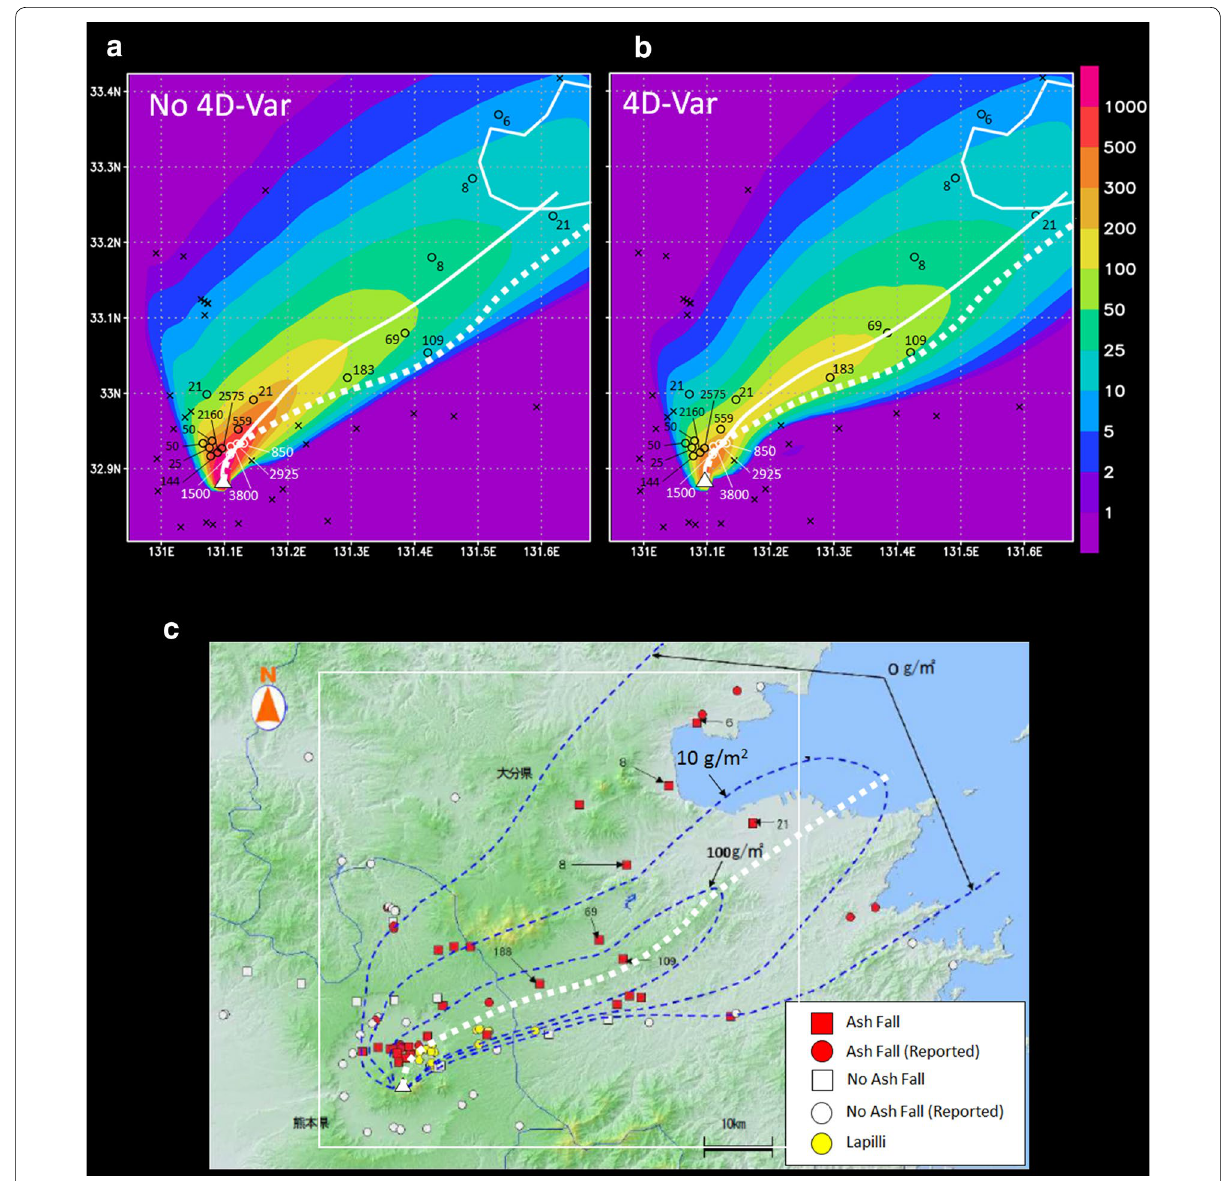
Fig. 2 a Ash fall forecast without 4D-Var. b Ash fall forecast with 4D-Var. c Ash fall observation [Regional Volcanic Observation and Warning Center, Fukuoka Regional Headquarters, JMA (2018) (minor postscripts were added by the author)]. The white triangle is plotted at the location of Aso volcano for all figures. In the left and centre figures, black cross-marks are “No Ash Fall and No Lapilli Fall”, black circles are “Ash Fall (g/m 2 ), No Lapilli Fall”, and white circles are “ash fall and lapilli fall (g/m 2 )”. White solid lines in the left and centre figures are the main axis of ash fall forecast. The white dotted line is the main axis estimated from